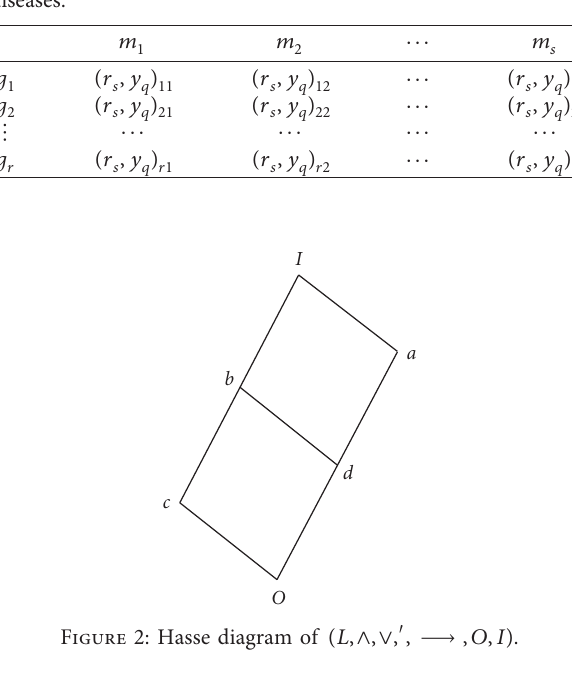
Table 3: Linguistic truth-valued formal context of patients and diseases.